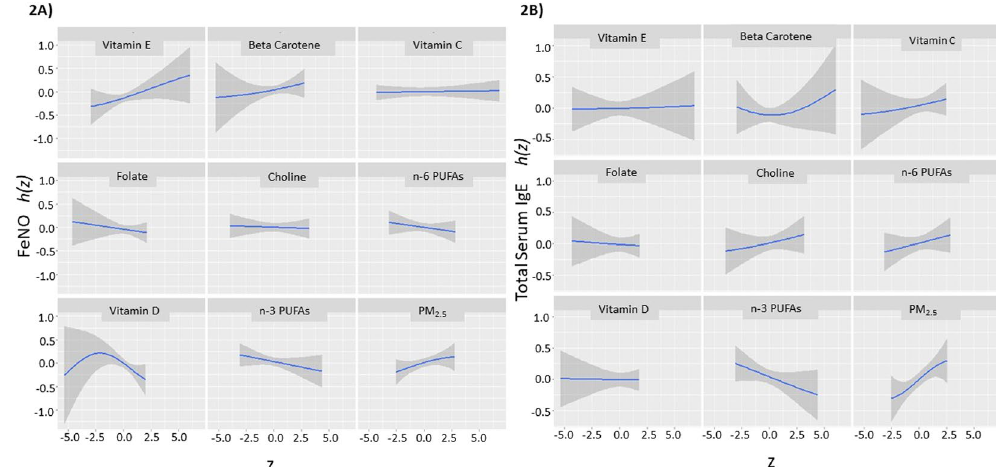
Figure 2. Estimated exposure response functions ( h (z)) for prenatal nutrient intake from foods alone (choline, n-6 PUFAs, n-3 PUFAs, Beta-carotene) and foods + supplements (Vitamin C, Vitamin E, Vitamin D, Folate), prenatal air pollution (PM 2.5 ) and allergic disease outcomes in adolescence. Plots show the estimated relationship between log-transformed z scores of exposures (z) and outcomes; shaded areas indicate 95% credible intervals. Plots are shown for outcomes FeNO ( A ) and Total Serum IgE ( B